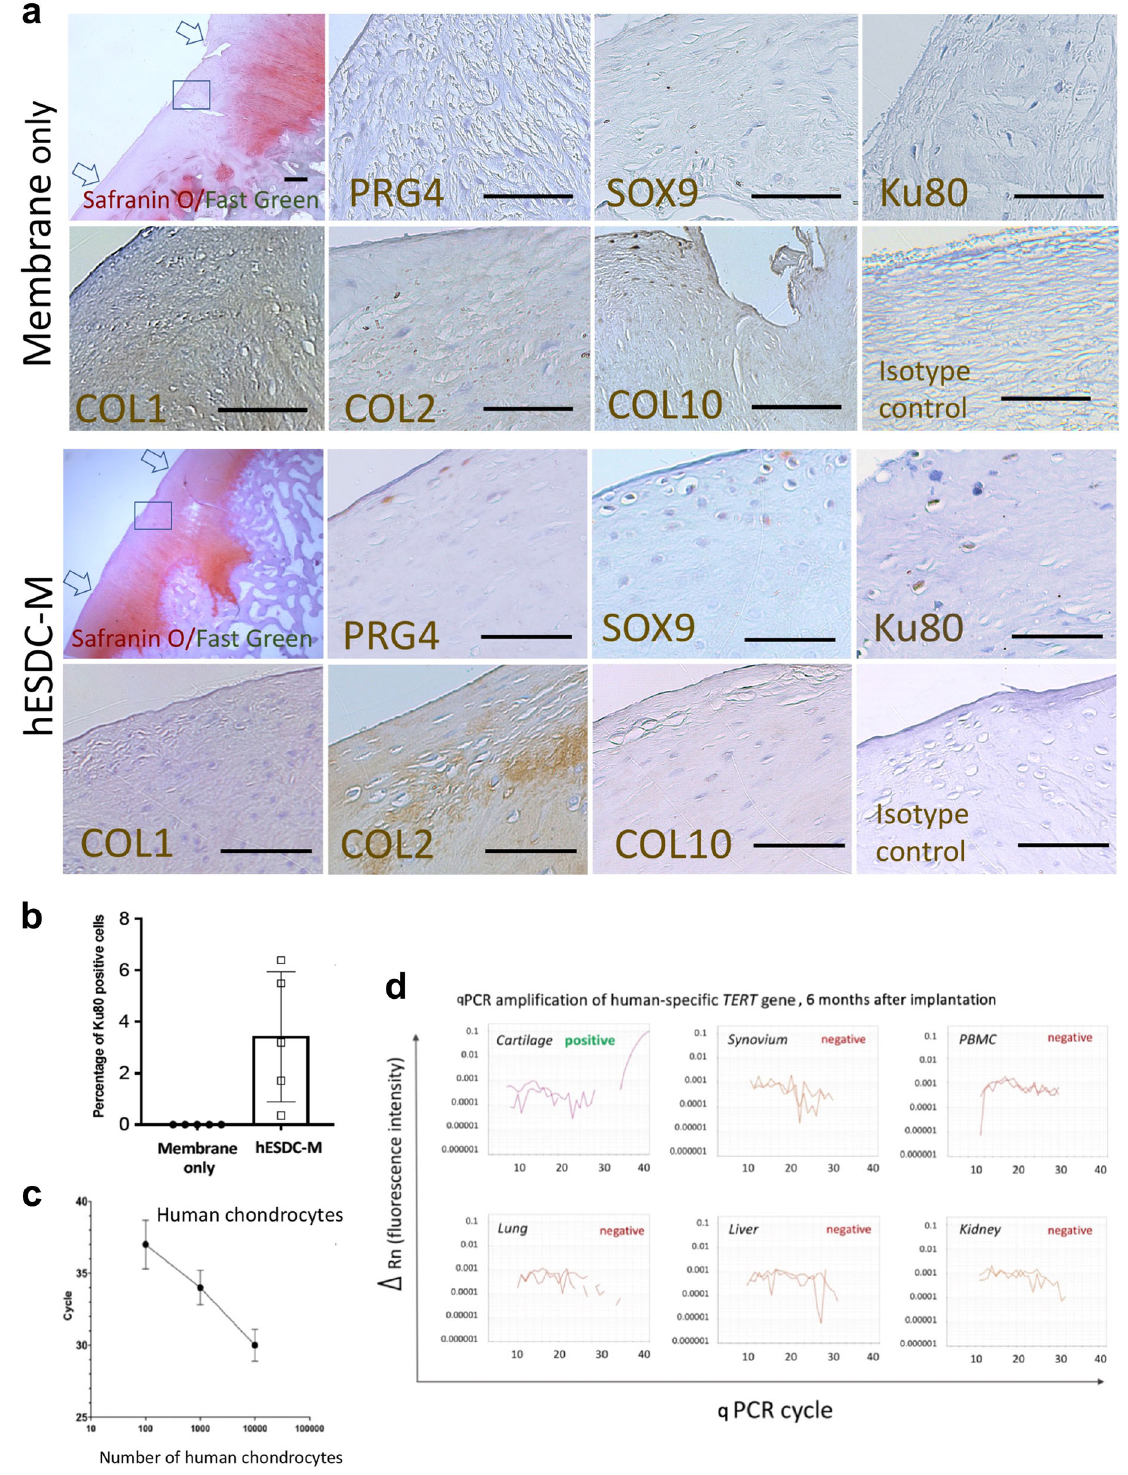
Fig. 4 hESDC-M treated defects evidence superior repair and contain both human and pig cells at 6 months. a Histochemical staining of the full defect (indicated by arrows) for Safranin O/Fast Green to assess glycosaminoglycans for control (membrane only) and treated (hESDC- M) animals. Representative images of immunohistochemical staining of the boxed area for human-speci fi c antigen Ku80 and zonal markers of articular cartilage for both control and treated femoral condyles are shown and highlighted with black triangles; scale bar = 200 μ m. b Quanti fi cation of Ku80 + cells (mean ± SD of 5 biological replicates). c qPCR analysis of human TERT gene. Standard curve constructed with human chondrocyte genomic DNA allowed reliable detection of as few as 100 human cells (mean ± SD of 3 biological replicates). d Genomic DNA extracted from the indicated tissues was analyzed for the human TERT gene. Representative ampli fi cation plots are shown; human cells were detected in all defects of animals treated with hESDC-M. PBMCs = peripheral blood mononuclear